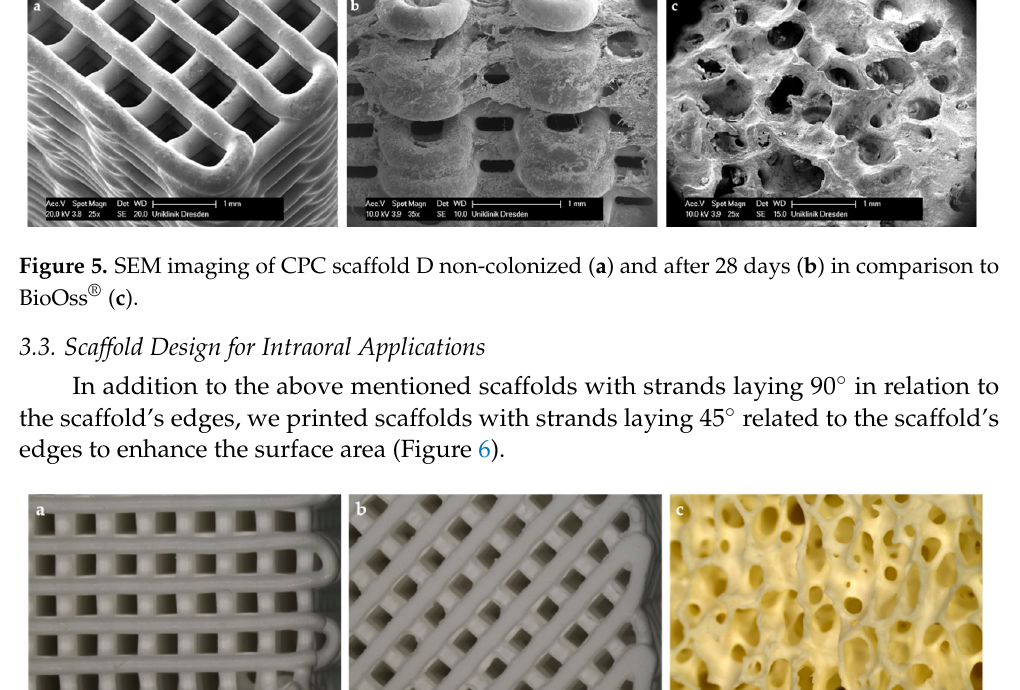
Table 2. Mechanical properties of scaffolds with different printing directions in comparison to the control.